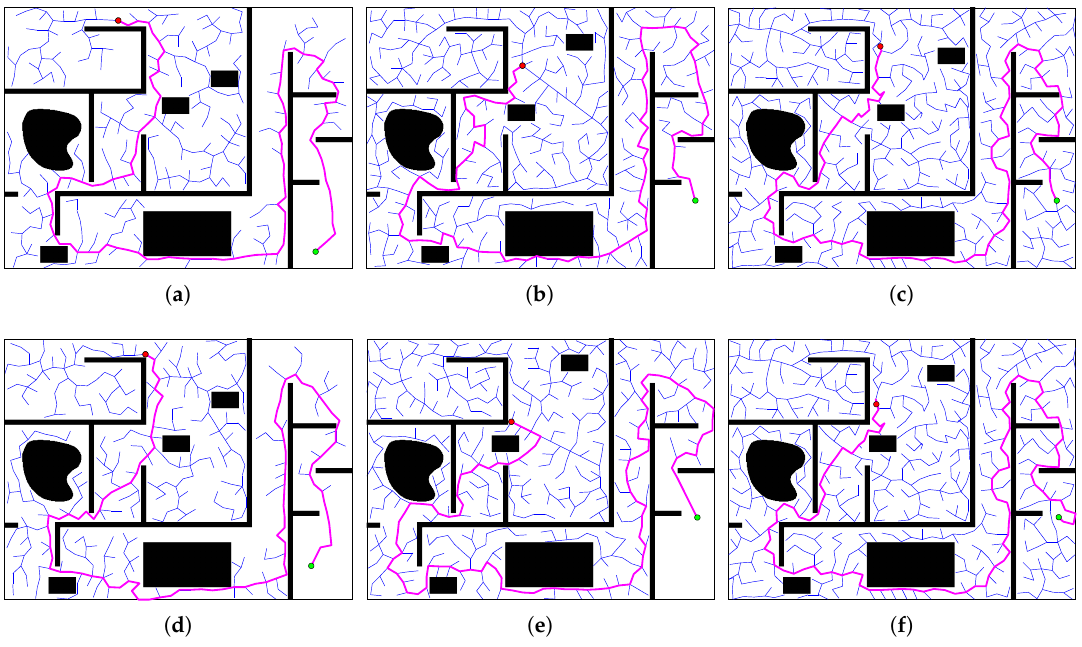
Figure 17. Comparison of the three algorithms. The blue lines are the trees, while the pink lines are the feasible paths. ( a , d ) Results of the execution extended rapidly-exploring random tree (ERRT) method in the 5th step and the 6th step. ( b , e ) The results of the SRRT method in the 8th step and the 9th step. ( c , f ) The results of the proposed rapidly-exploring random tree (RRT) method in the 7th step and the 8th step.